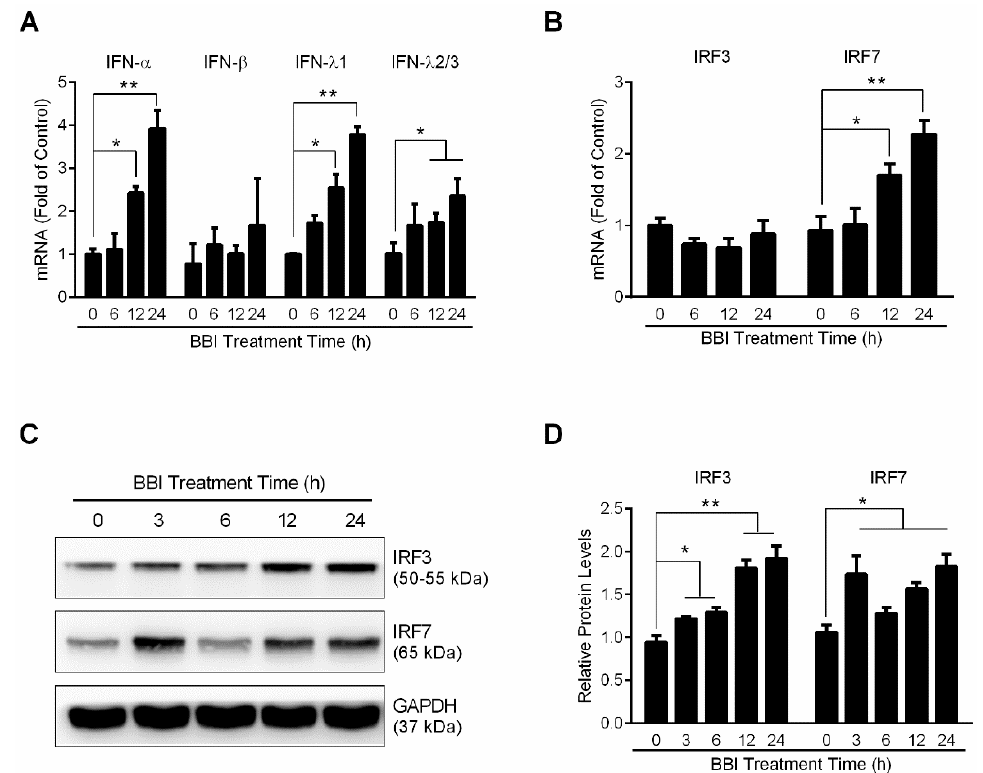
Figure 3. Effect of BBI on IFNs and IRFs expression in End1/E6E7 cells. End1/E6E7 cells were treated with or without 200 μ g/mL BBI for indicated times. ( A , B ) Cellular RNAs extracted from cells were subjected to the real-time RT-PCR for IFN- α , IFN- β , IFN- λ 1, IFN- λ 2/3, IRF3, IRF7 and GAPDH mRNA. ( C ) Cellular proteins were collected and subjected to Western blot with the antibodies against IRF3 and IRF7. Representative data from three independent experiments were shown (* p < 0.05, ** p < 0.01). ( D ) Densitometry analysis of the blots shown in C was performed with ImageJ 1.44 software.